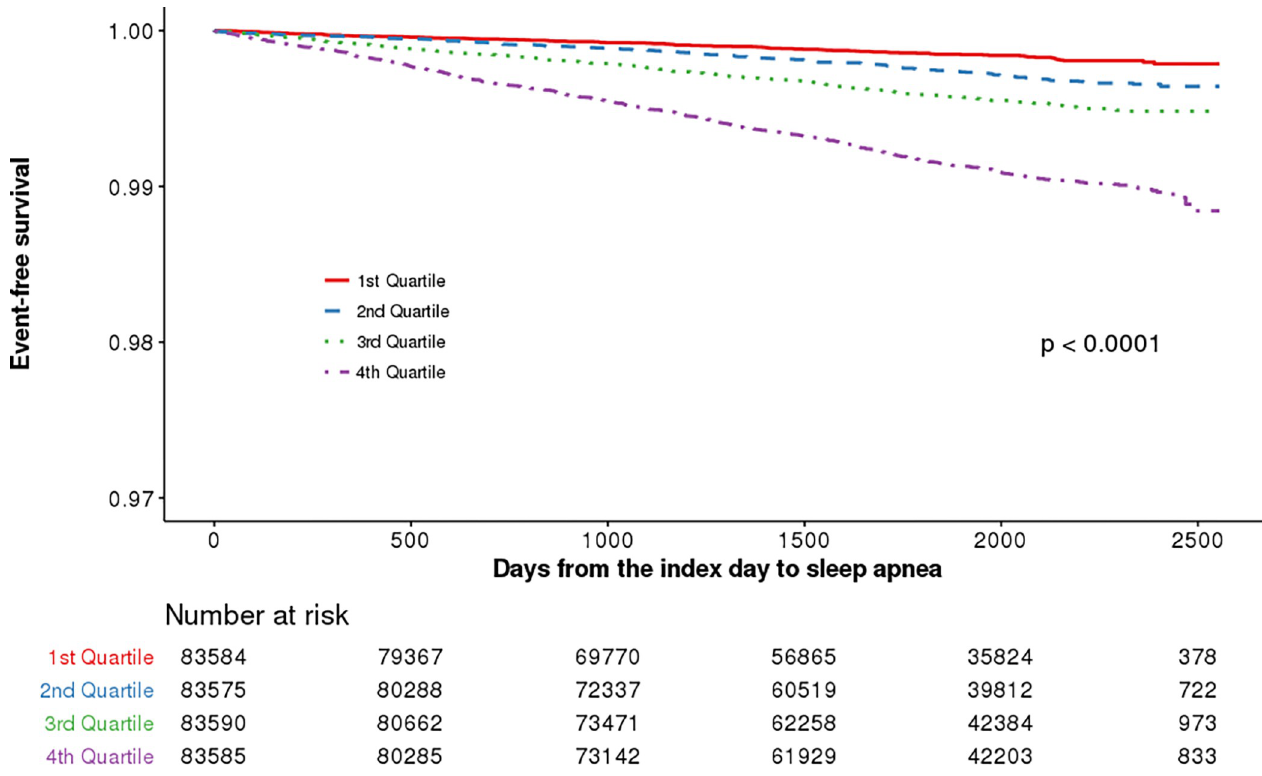
Fig 2. Cumulative incidence of new-onset sleep apnea (SA), according to their quartiles.